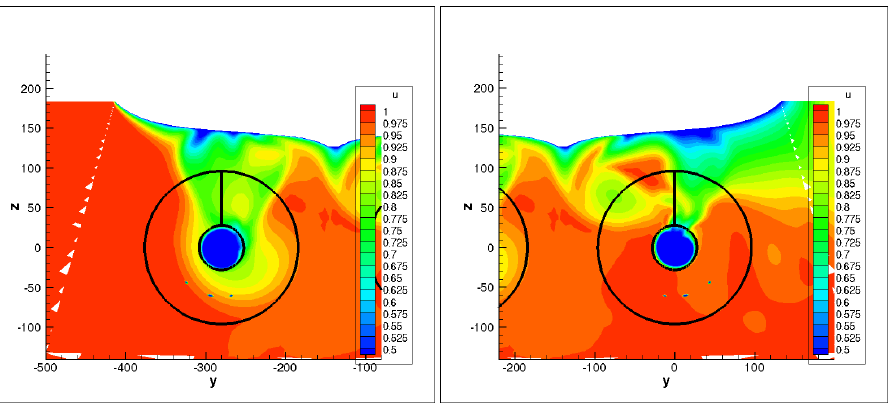
Figure 9. Nominal wake of the model hull without rudders in steady drift motion: RANS computa- tions of the axial velocity component on the transverse plane close to the propeller shaft end. ( Left ) portside. ( Right )